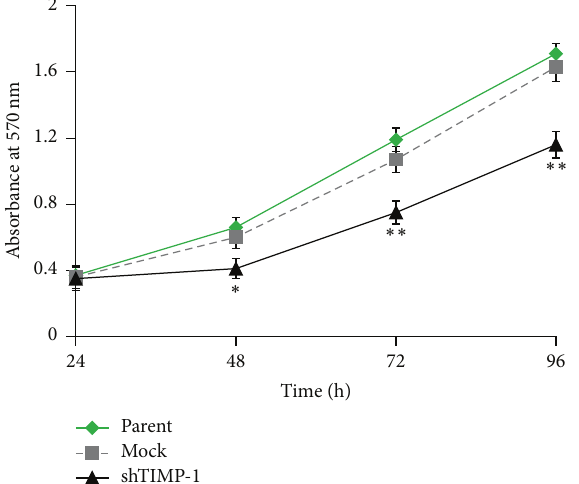
Figure 3: siRNA-mediated downregulation of TIMP-1 inhibits the proliferation of ADSCs. Cell growth curves during 96 h were evaluated by MTT assay. Data are the mean absorbance values of three measurements and the bars represented SD of the mean. ∗ 𝑃 < 0.05 and ∗∗ 𝑃 < 0.01 versus mock-shRNA groups. Parent: uninfected ADSCs; mock: control lentivirus infected ADSCs; shTIMP-1: shRNA-TIMP-1 lentivirus infected